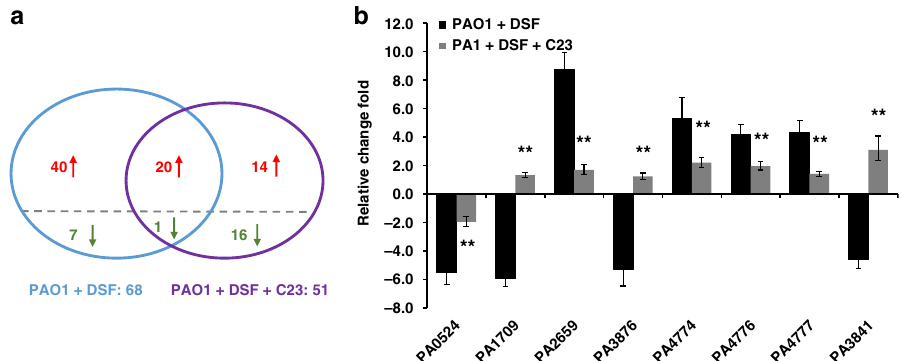
Fig. 5 Effects of DSF and C23 on P. aeruginosa gene expression during infection. a Venn diagrams showing results of comparative transcriptome pro fi ling of the effects of addition of either DSF or DSF with C23 on gene expression in wild-type P. aeruginosa during mouse lung infection. The comparator is P. aeruginosa in mouse lung with no compound addition. Genes signi fi cantly upregulated (>1.25-fold, p adj < 1 × 10 − 5 ) are indicated in red, those signi fi cantly downregulated are indicated in green. The complete set of regulated genes is depicted in Supplementary Table 3. b qRT – PCR analysis of expression levels of selected genes implicated in virulence and bio fi lm formation in response to addition of DSF or DSF and C23 in wild-type P. aeruginosa during mouse lung infection. Transcript levels of PA0524 , PA1709 , PA2659 , PA3876 , PA4774 , PA4776 , PA4777 , and PA3841 were examined. The qRT – PCR data were normalized to proC and are presented as the fold change with respect to the wild type for each gene. Data (means ± standard deviation) are from one representative experiment ( n = 3). A p- value of <0.05 was considered statistically signi fi cant and is designated in the fi gures with an asterisk. Double asterisks indicate p- values of